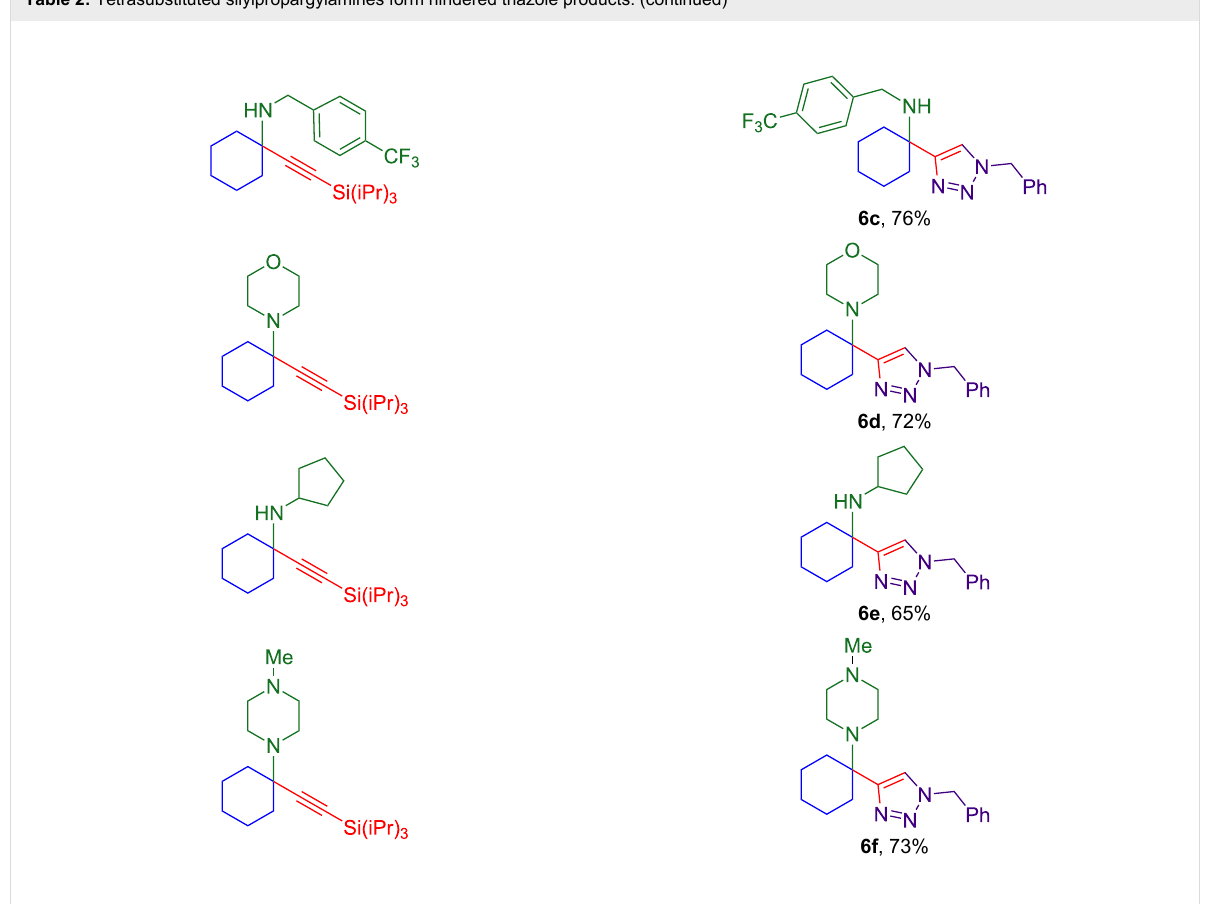
Table 2: Tetrasubstituted silylpropargylamines form hindered triazole products.